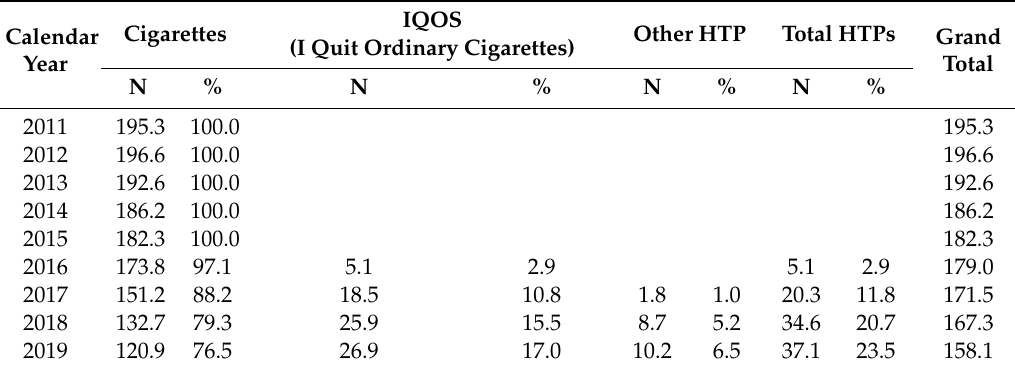
Table 1. Sales of tobacco products in Japan, 2011–2019 1 .